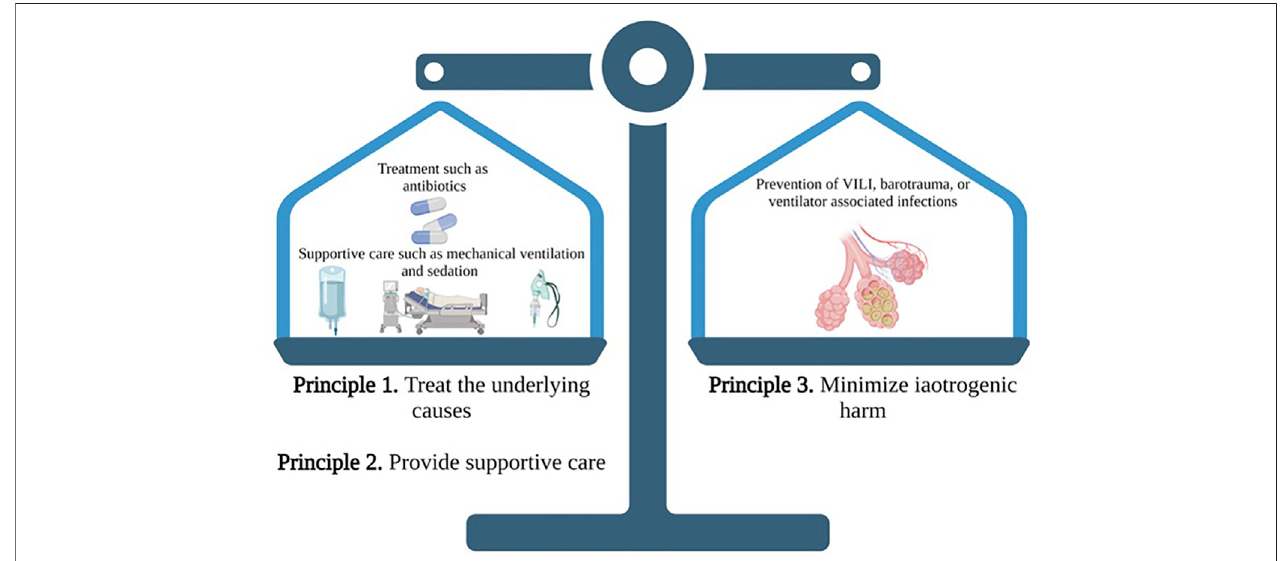
FIGURE 2 | The three principles of critical care: A proposed schematic of balancing risks and harms of various interventions. Two special objects (must be kept) in viewwithregardtodisease,namely,todogoodortodonoharm — Hippocrates.Withthethreeprinciplesofcriticalcare,thetwoprinciplesoftreatmentoftheunderlying cause and provision of supportive care must be counterbalanced by the third principle of minimizing iatrogenic harm. When applied to a mechanically ventilated patient, treating the underlying cause may include pharmacotherapy (e.g., antibiotics) and non-pharmacotherapy (e.g., chest tubes); supportive care may be providing adequate oxygenation and ventilation while the therapies reverse the underlying cause (e.g., invasive positive pressure ventilation); and minimizing harm may include preventingVILIorventilatorassociatedinfections.Inthecaseofreversetriggering,twosupportivecaremodalities(mechanicalventilationandsedation)mayincreaserisk of iatrogenic harm, and careful consideration is warranted to maintain appropriate balance. Source Hanna Azimi, PharmD. Created with Biorender.com.